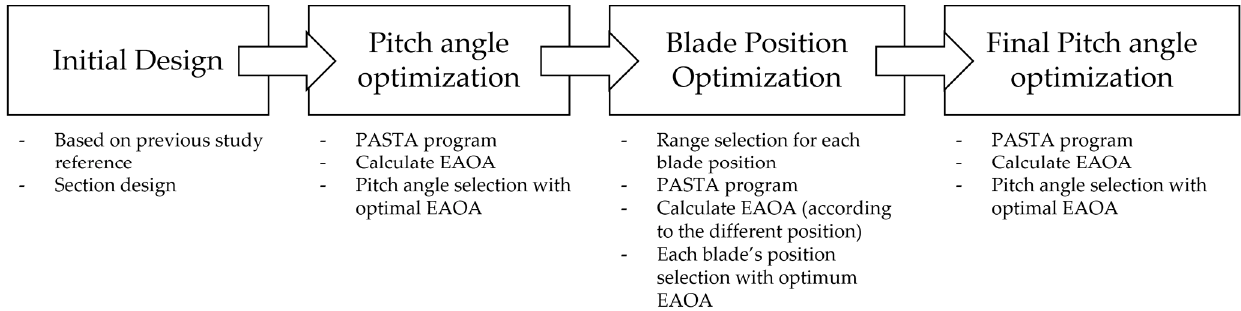
Figure 9. Blade Position Optimization Procedure.